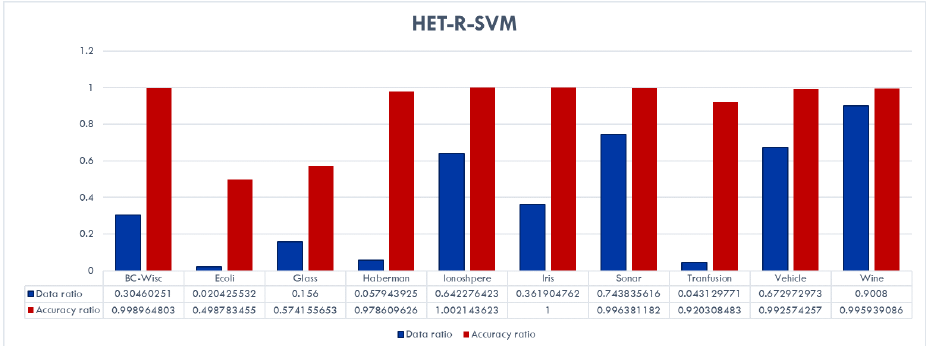
Figure 9. Performance of HET-R-SVM: data ratio vs. accuracy